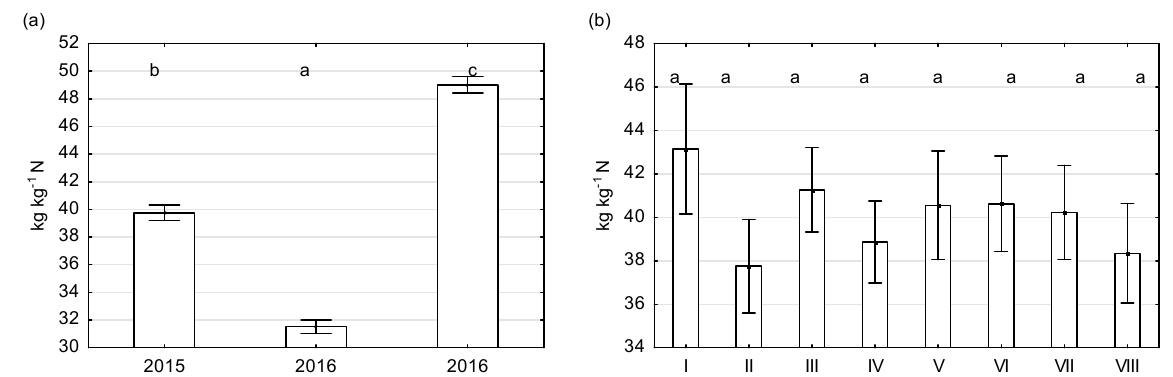
Figure 3. Internal nitrogen utilization efficiency (IE) depending on a study year ( a ) and applied fertilization ( b )—mean ± SE; data marked with same letters do not differ significantly at p < 0.05; figure ( a ) years of experiment (2015, 2016 and 2017), figure ( b ) number of object (I–VIII)—see Table 1. The IRE values were statistically differentiated in the research years (Figure 4a). The highest RIE (31.97 kg 1000 kg − 1 ) occurred in the second year of the experiment, which was characterized by the highest maize straw and grain yields. The lowest RIE (20.49 kg 1000 kg − 1 ) was determined in the third year, which was excessively wet. According to the average results for the entire study period, the tested fertilizers did not have a significant effect on the uptake of nitrogen per 1 ton of grain with the adequate quantity of straw, which varied from 24.34 to 27.53 kg 1000 kg − 1 (Figure 4b). The smallest RIE was determined in the control (no nitrogen fertilization), while the highest one occurred in the treatment where ammonium nitrate was applied before sowing and urea as a top-dressing fertilizer.